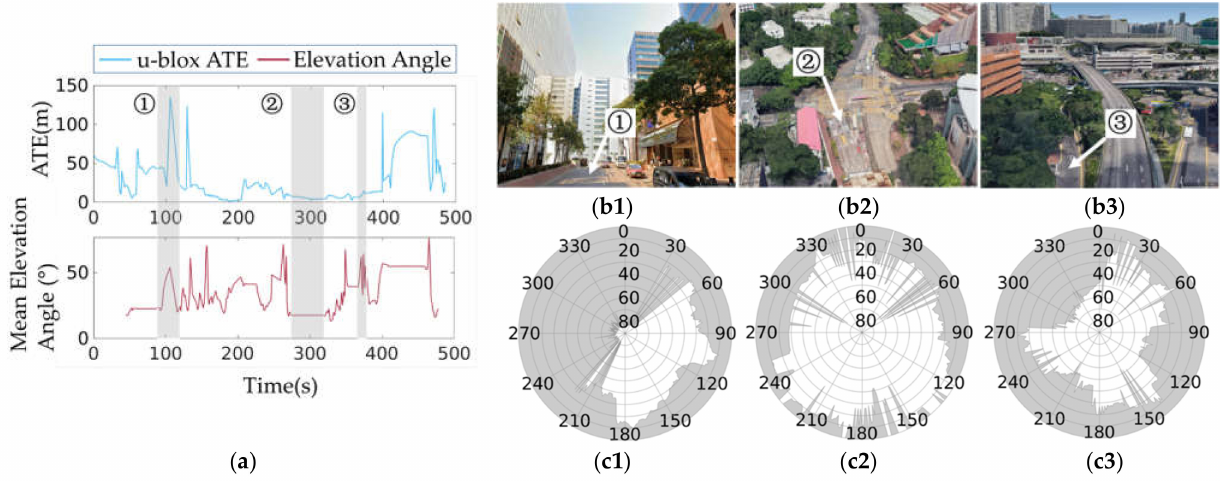
Figure 6. ( a ). The top panel shows the ATE of the u-blox GNSS-RTK solutions calculated by RTKLIB [7] collected in urban-1. The bottom panel shows the mean elevation angle mask of the local point cloud map around the correspondent u-blox epoch. 1 (cid:13) , 2 (cid:13) , and 3 (cid:13) denote representative cases. ( b ). ( b1 – b3 ) are streetscapes of the three places denoted in ( a ) respectively. ( c ). ( c1 – c3 ) are the sky masks of the three places denoted in ( a )